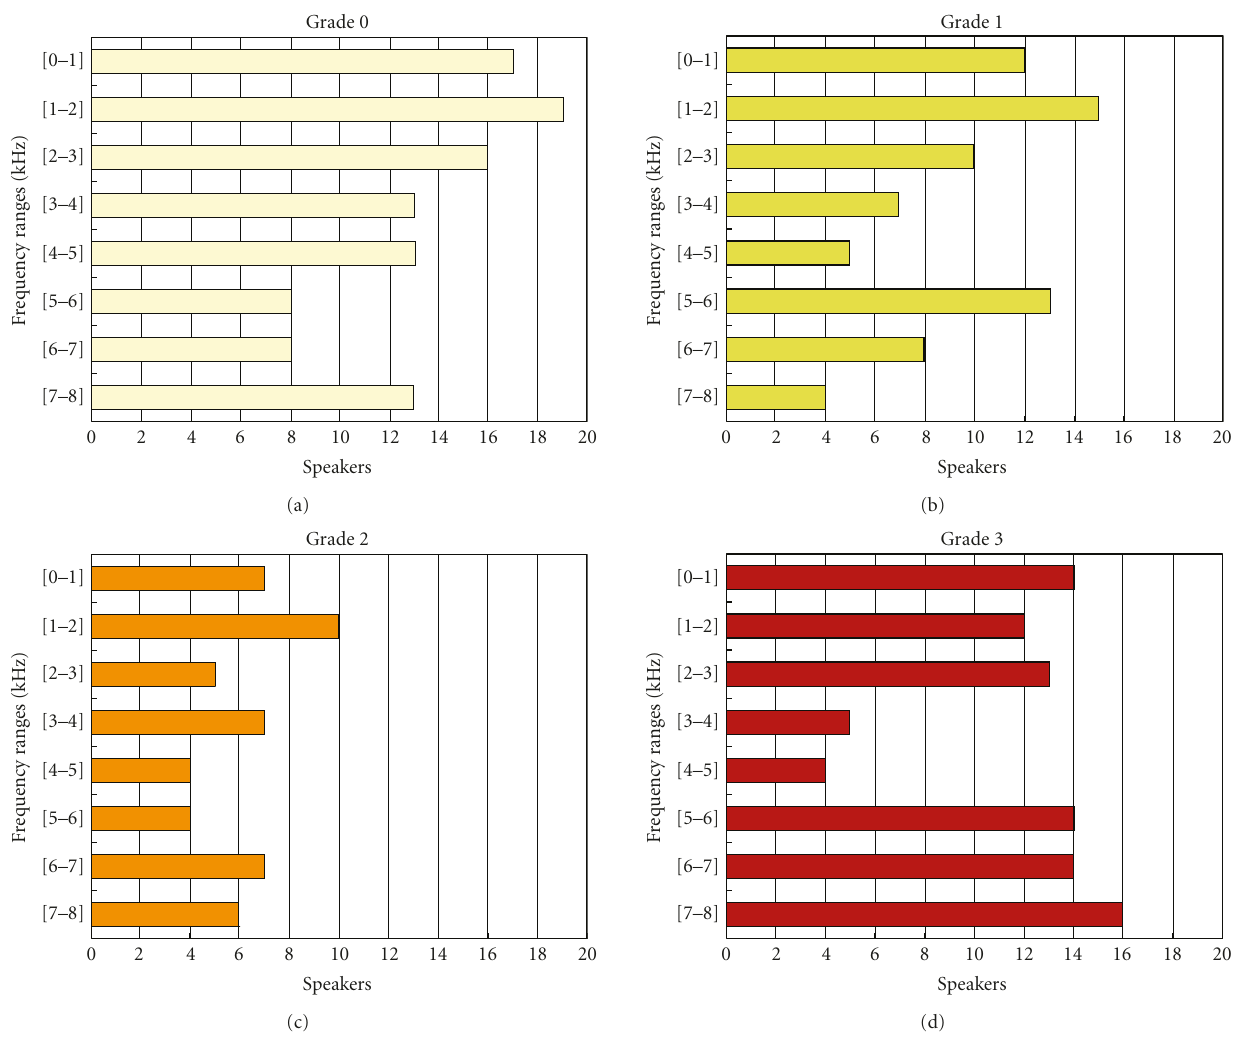
Figure 3: Number of voices correctly classified from the 4-G classification following 1000 Hz-width frequency subbands (24 LFSC).